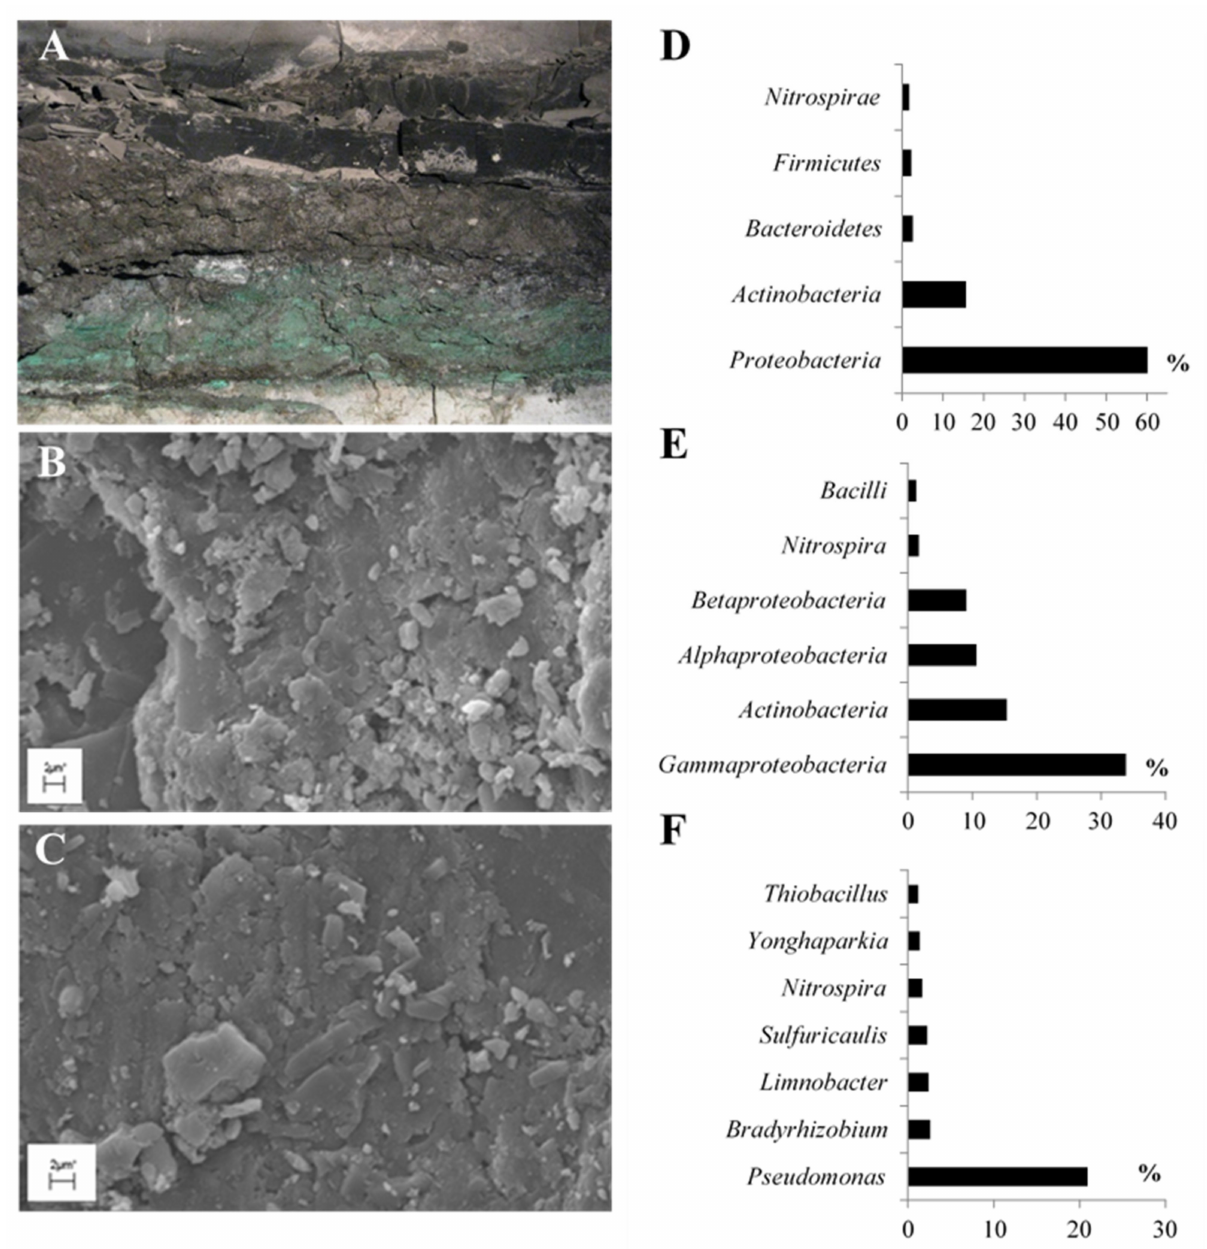
Figure 2. Bacterial community inhabiting shale rock: macroscopic micrograph ( A ) and scanning electron micrographs ( B , C ). Diversity of dominating (>1%) phyla ( D ), classes ( E ), and genera ( F ) identified in the bacterial